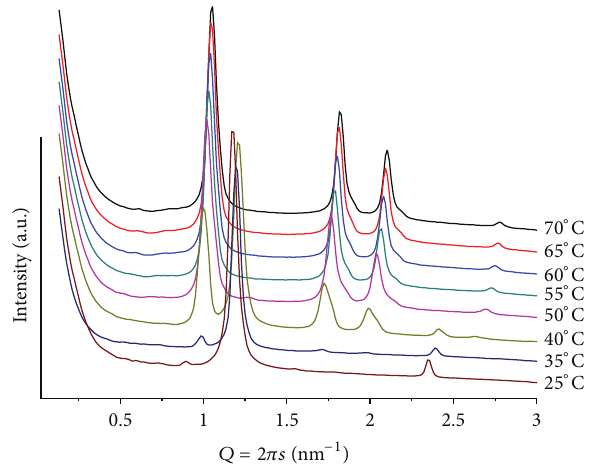
Figure6:SAXSpatternsatdifferenttemperaturesforPOPE/BANQ, mr = 50 and pH = 4 .